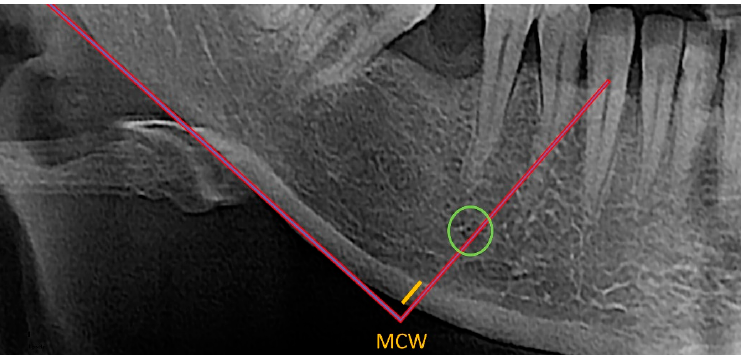
Figure 1. Evaluation of the thickness (yellow line) of the cortical bone at the lower border of the mandible (MCW index) below and distally of the mental foramen (green circle).